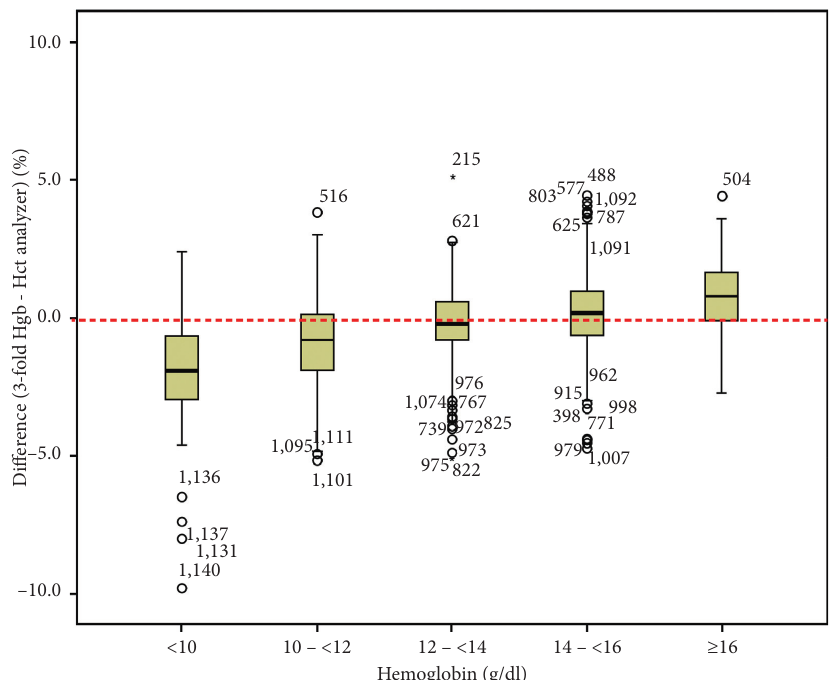
Figure 5: Difference between hematocrit calculated from the three-fold conversion and the analyzer by hemoglobin levels. Data are presented in box and whisker plots with median (horizontal line), interquartile range (box), and maximum values within 1.5 of interquartile range